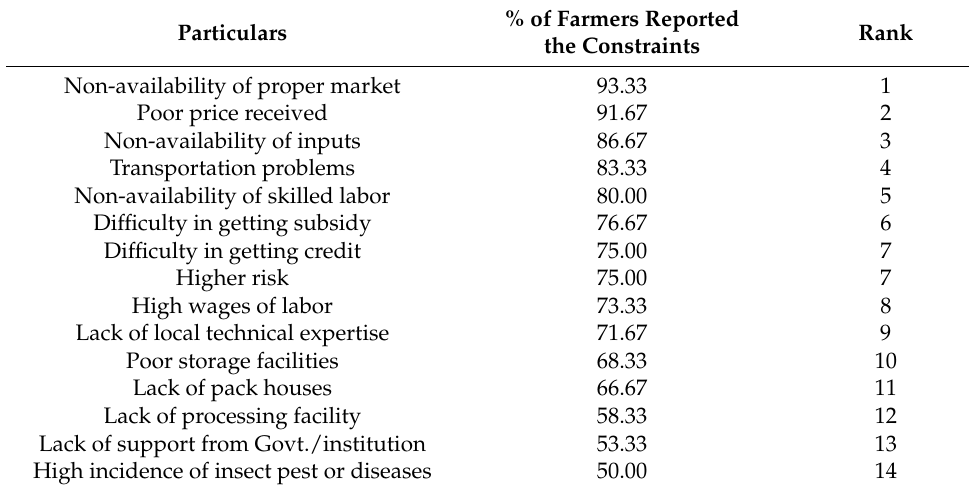
Table 21. Constraints faced by polyhouse